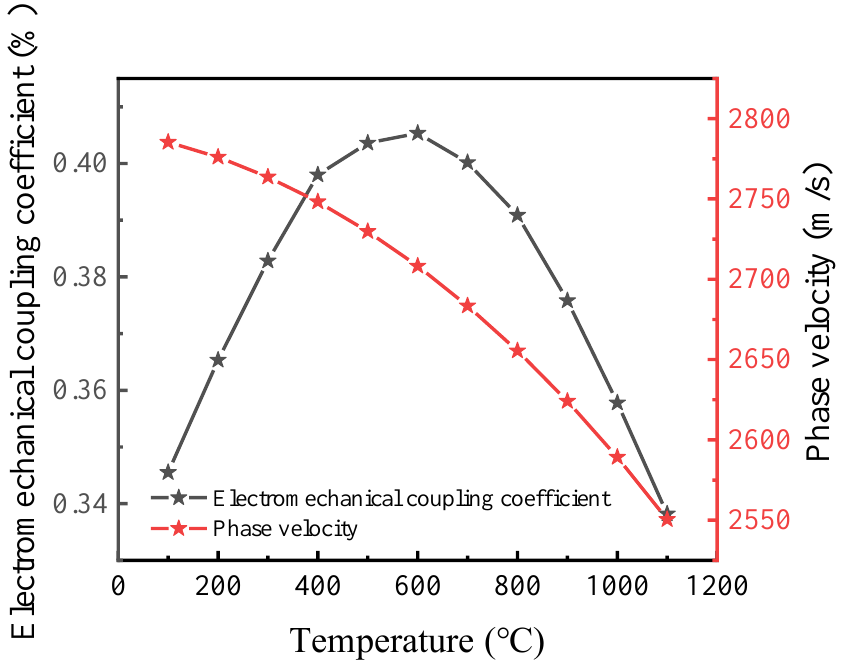
Figure 3. The electromechanical coupling coefficient (K 2 ) and phase velocity (v) with different tem- perature.